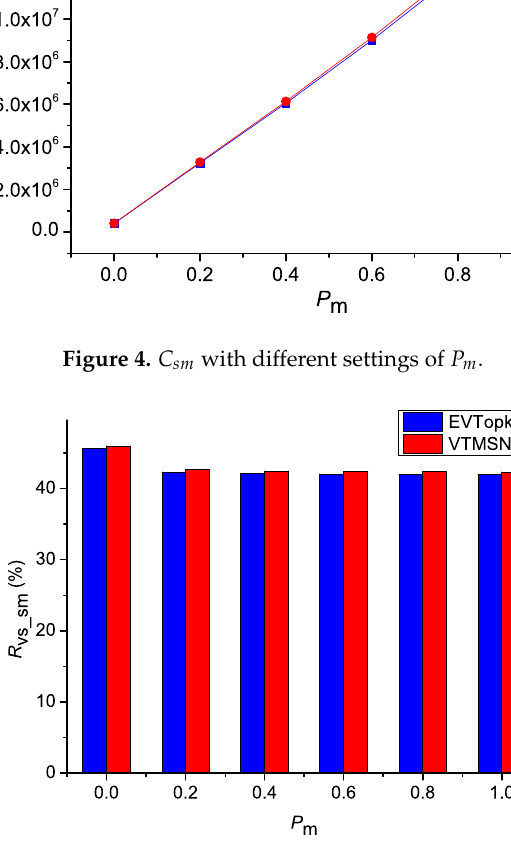
Figure 5. R vs _ sm with different settings of P m